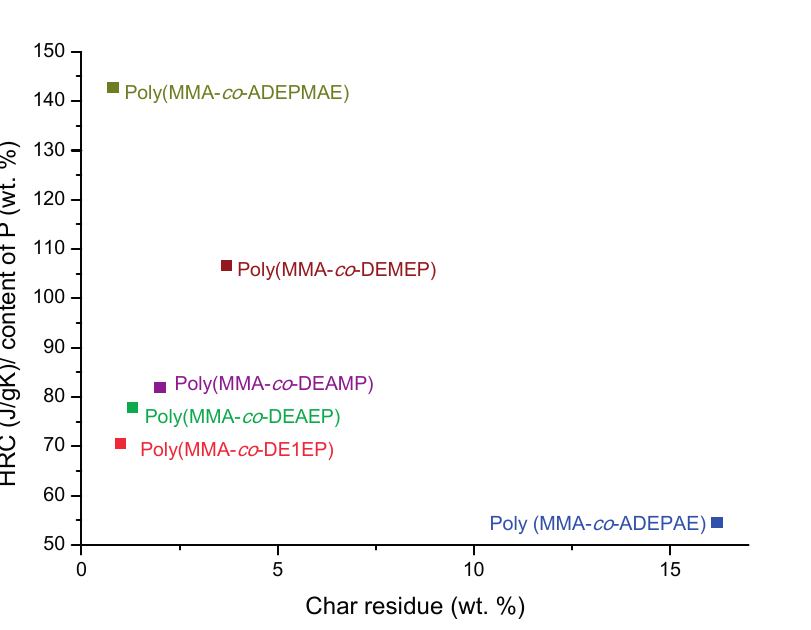
Figure 6. Ratio of HRC to the content of P versus PCFC char residue for copolymers of MMA.